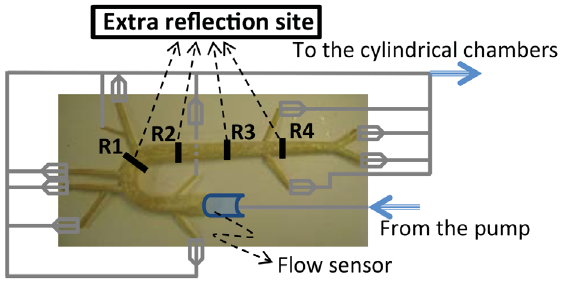
Figure 3. The aortic simulator for setup 3. An extra reflection site (a ring) was placed at different locations along the aorta marked by numbers 1–4. They are located at approximately 15, 25, 35 and 45 cm from the aortic